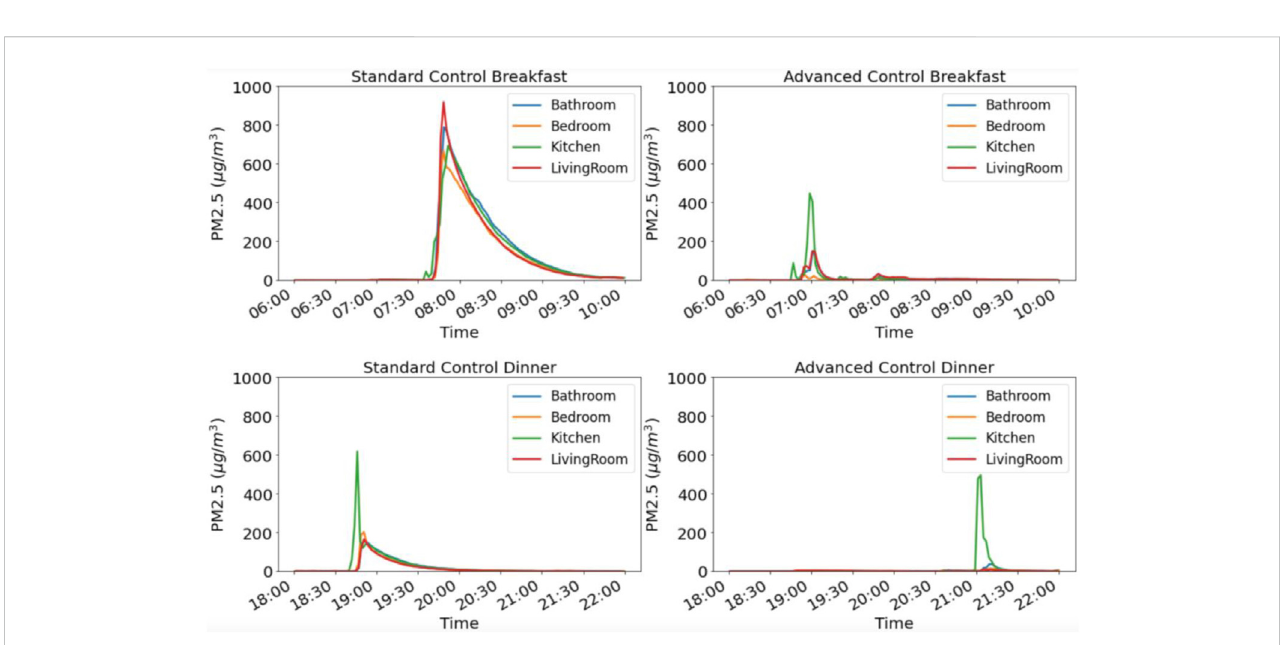
FIGURE 4 PM2.5 concentration pro fi les for breakfast and dinner cooking in the standard and automated residential